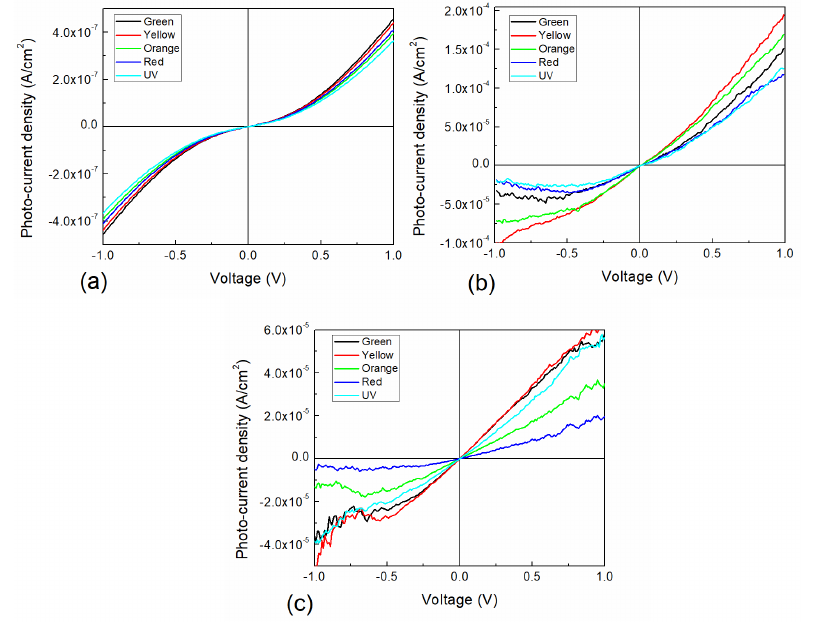
Figure 9. Voltage-dependent photo-current density curves for doped ( a ) CoPc, ( b ) ZnPc and ( c ) CuPc for different incident light colors.